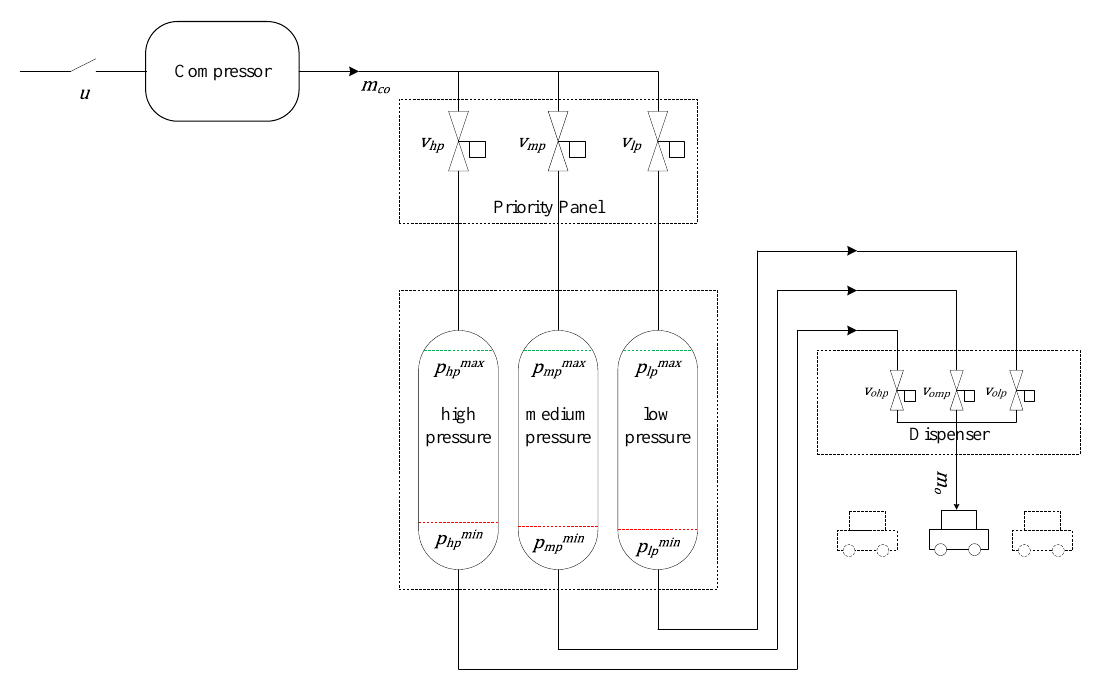
Figure 1. Layout of the fast-fill CNG